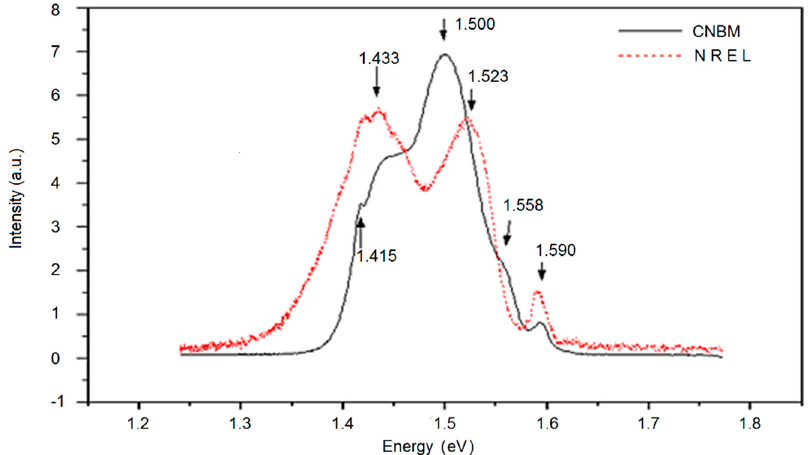
Figure 2. Backside luminescence (10 K) of CdS / CdTe solar cells grown in the NREL laboratory and CNBM New Energy Materials Research Center, respectively.